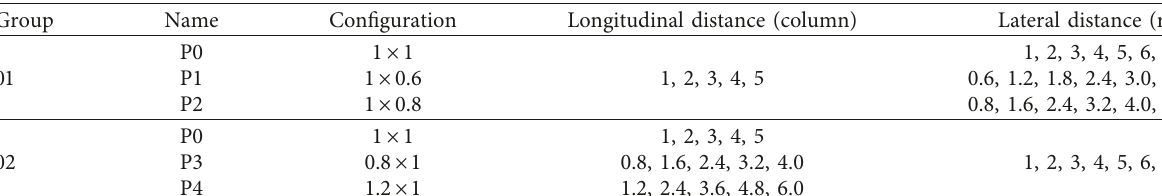
Figure 25: Error bar of coherence coefficients between each two participants for the reference configuration. Table 7: Configurations of groups according to lateral and frontal distances.